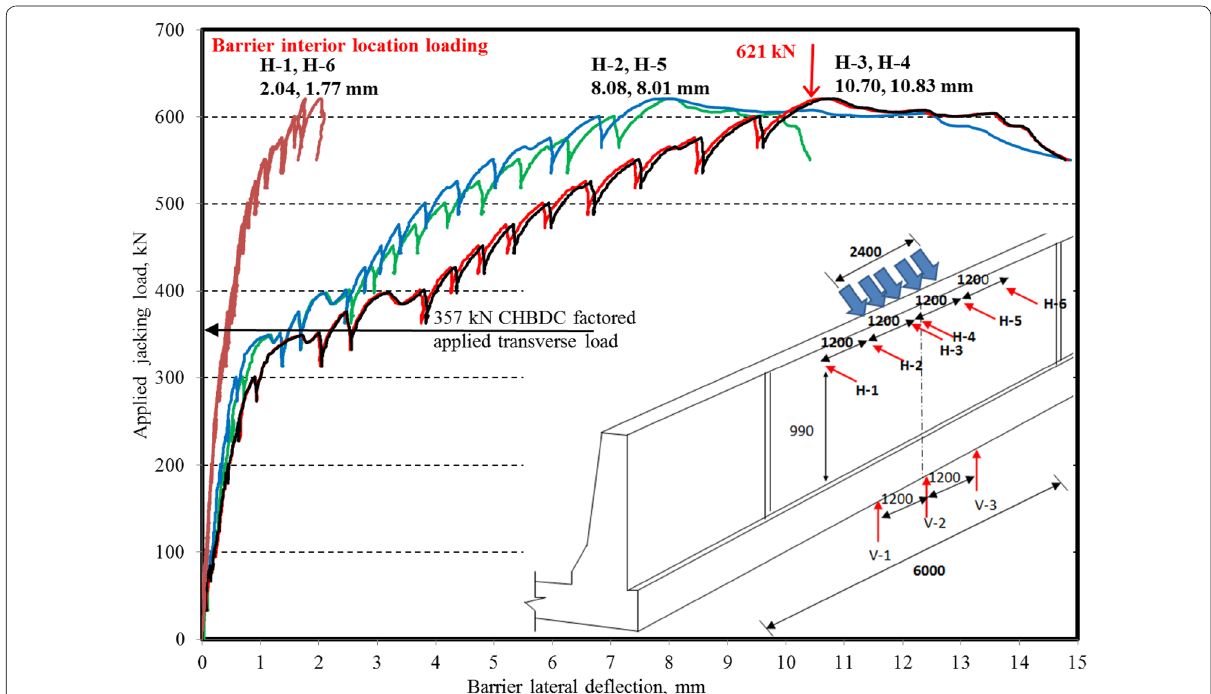
Fig. 14 Load-deflection relationship for barrier segment loaded at mid-length between two control joints.